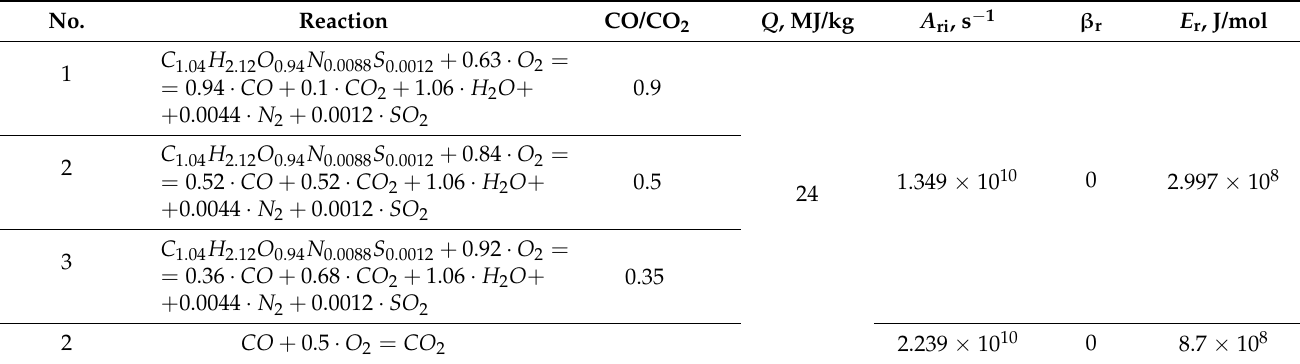
Table 6. Description of chemical reactions